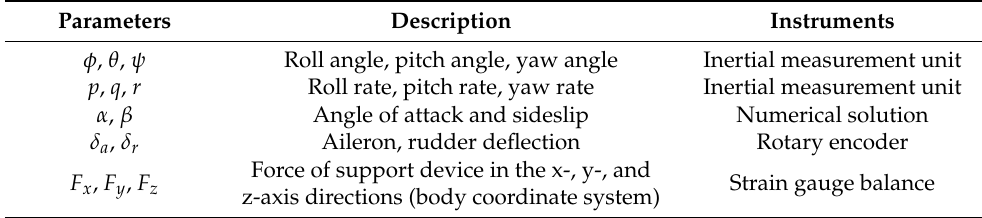
Figure 4. Layout of the test model. Table 1. Measurable data from wind tunnel virtual flight test.